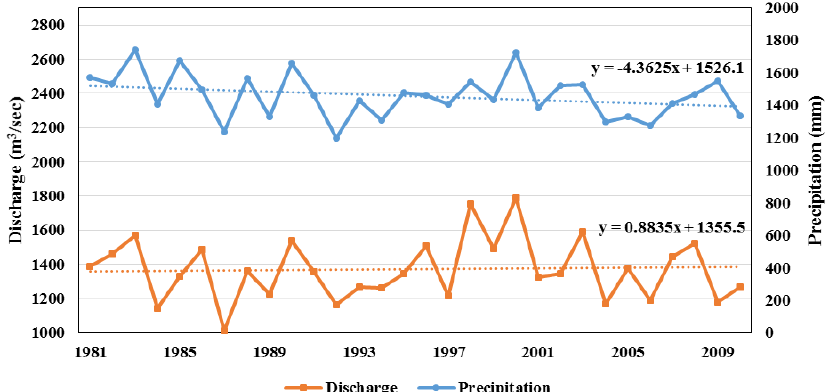
Figure 9. Annual average precipitation of KRB and river discharge at its outlet at Chisapani.